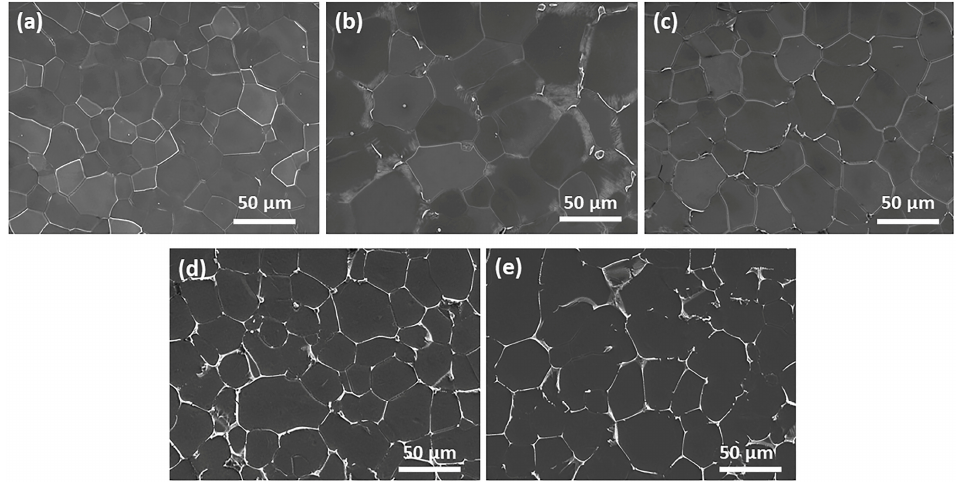
Figure 2. Scanning electron microscope (SEM) images of the as-cast alloys: ( a ) Alloy1, ( b ) Alloy2, ( c ) Alloy3, ( d ) Alloy4 and ( e ) Alloy5.